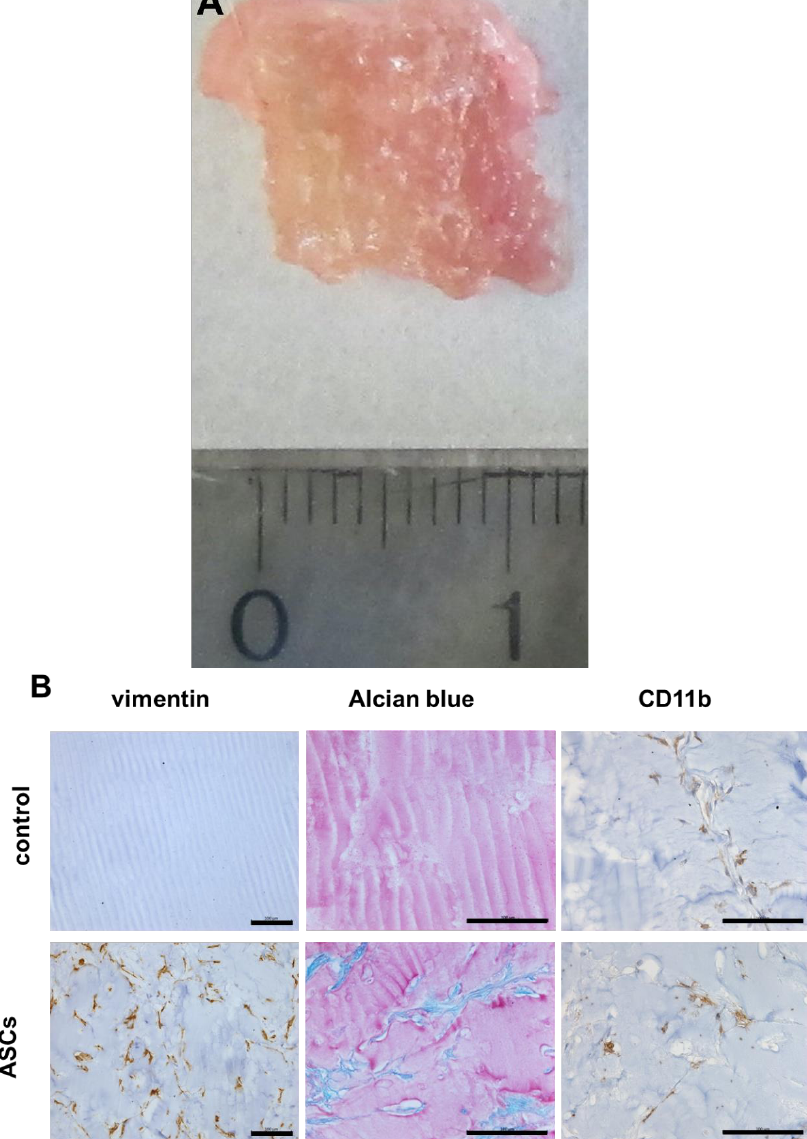
Figure 6. Constructs were implanted subcutaneously into SCID mice and were explanted after 4 weeks. ( A ) Macroscopic image of an explanted ASC-printed construct. ( B ) Paraffin sections of explants were stained with a human-specific antibody against vimentin to visualize ASCs or with an anti-CD11b antibody for the visualization of mouse innate immune cells. The alcian blue staining of paraffin sections was performed to visualize sulfated proteoglycans. Representative images images from each group (n = 6) are shown. Scale bars: 100 µm.